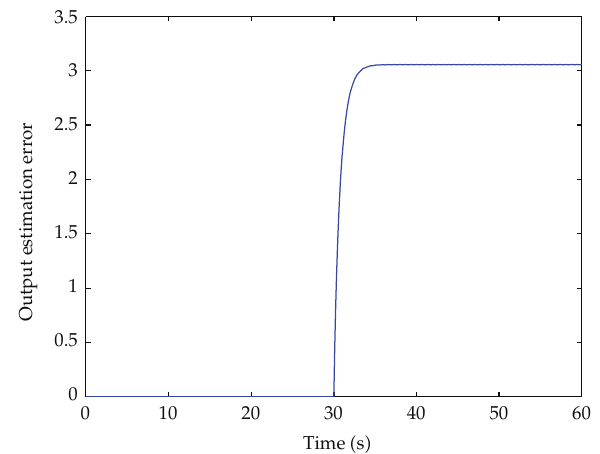
Figure 5: Output estimation error in case 3 using a high frequency